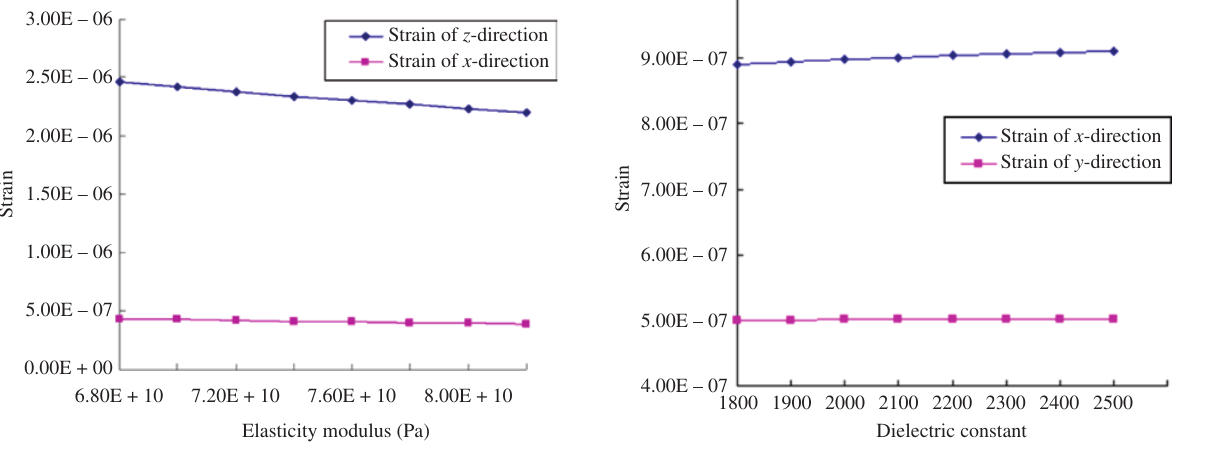
Figure 5: Relationship between piezoelectric elastic modulus and strain of composite material ( U = 10 V).